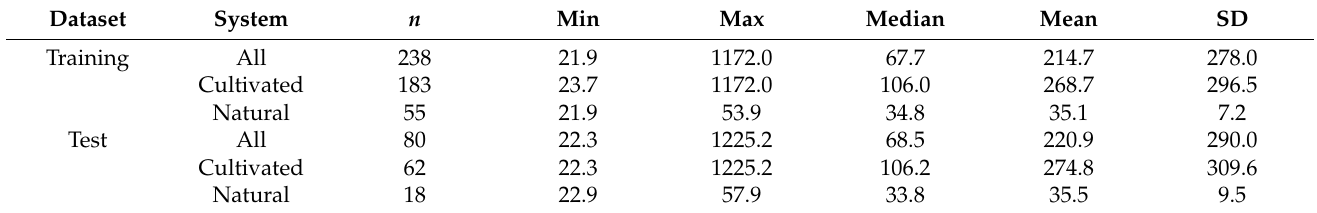
Table 2. Summary statistics of soil oxalate-extractable P